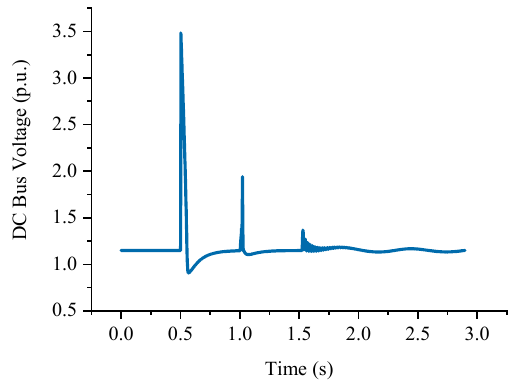
Figure 8. DC bus voltage curve under PI control.